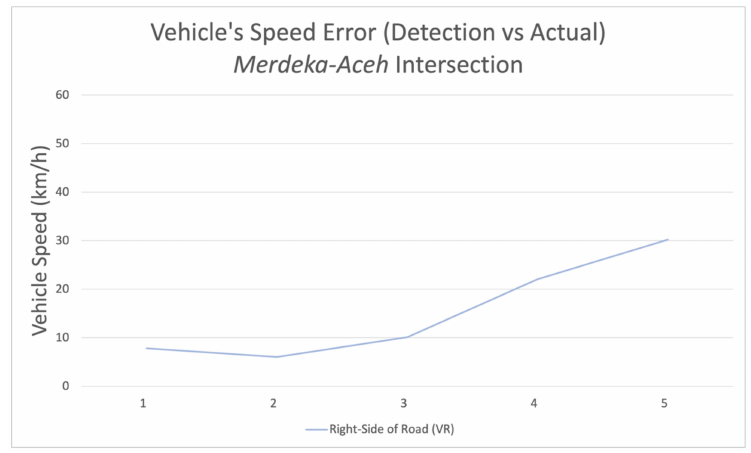
Figure 19. Average error rate of vehicle speed calculation on Merdeka-Aceh